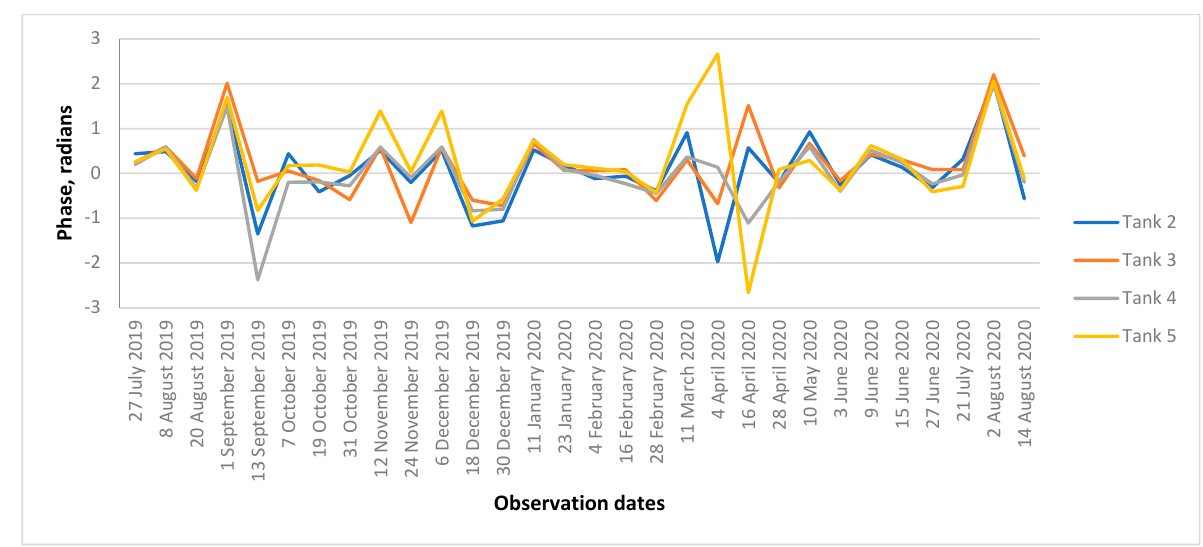
Figure 10. Interferometric coherence (no units) of tanks backscatter in 2019–2020.